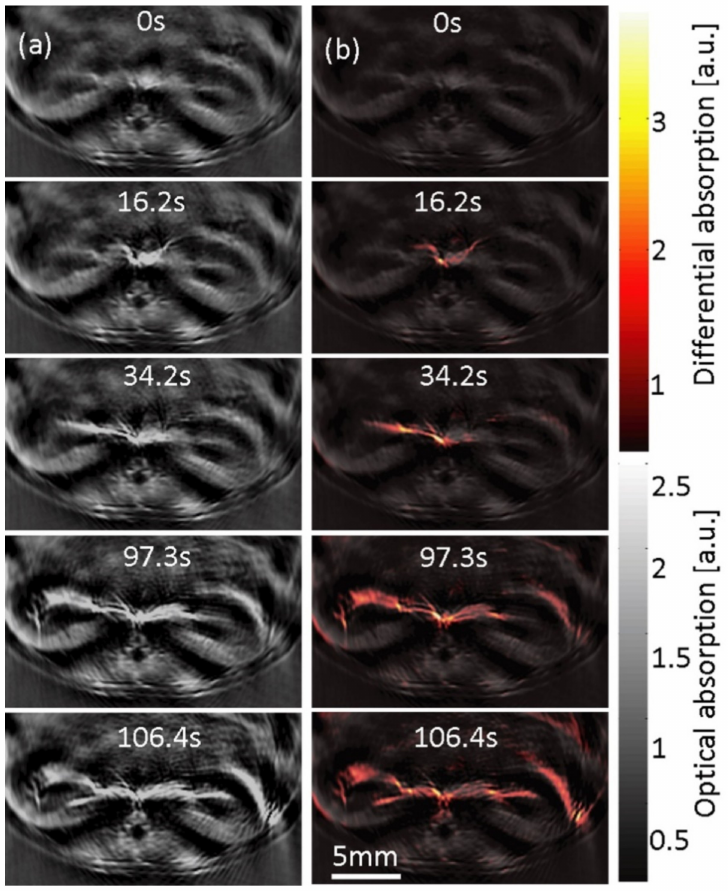
Figure 7. Tomographic optoacoustic imaging of indocyanine perfusion kinetics in murine kidneys. ( a ) Cross-sectional optoacoustic images over time of mouse kidneys at 800 nm after ICG injection; ( b ) the absorption difference with the single-wavelength image before injection to show increased ICG perfusion over time. Adapted with permission from [95]. This image is not published under the terms of the CC-BY license. © The Optical